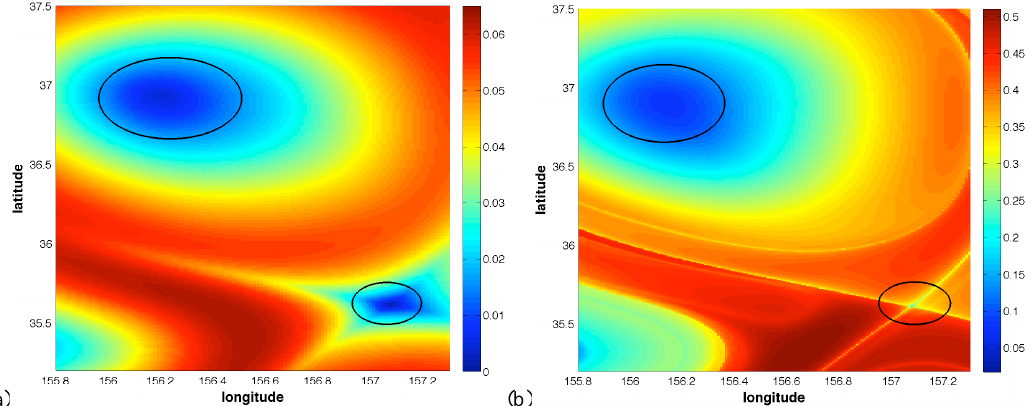
Fig. 10. Contour plots of the function M on 2 May 2003 in the nearby of two positions which are candidates to be DT. (a) τ = 2 days; (b) τ = 15